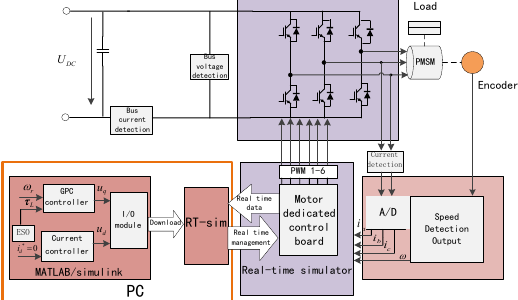
Figure 5. The experimental configuration of the PMSM drive and control